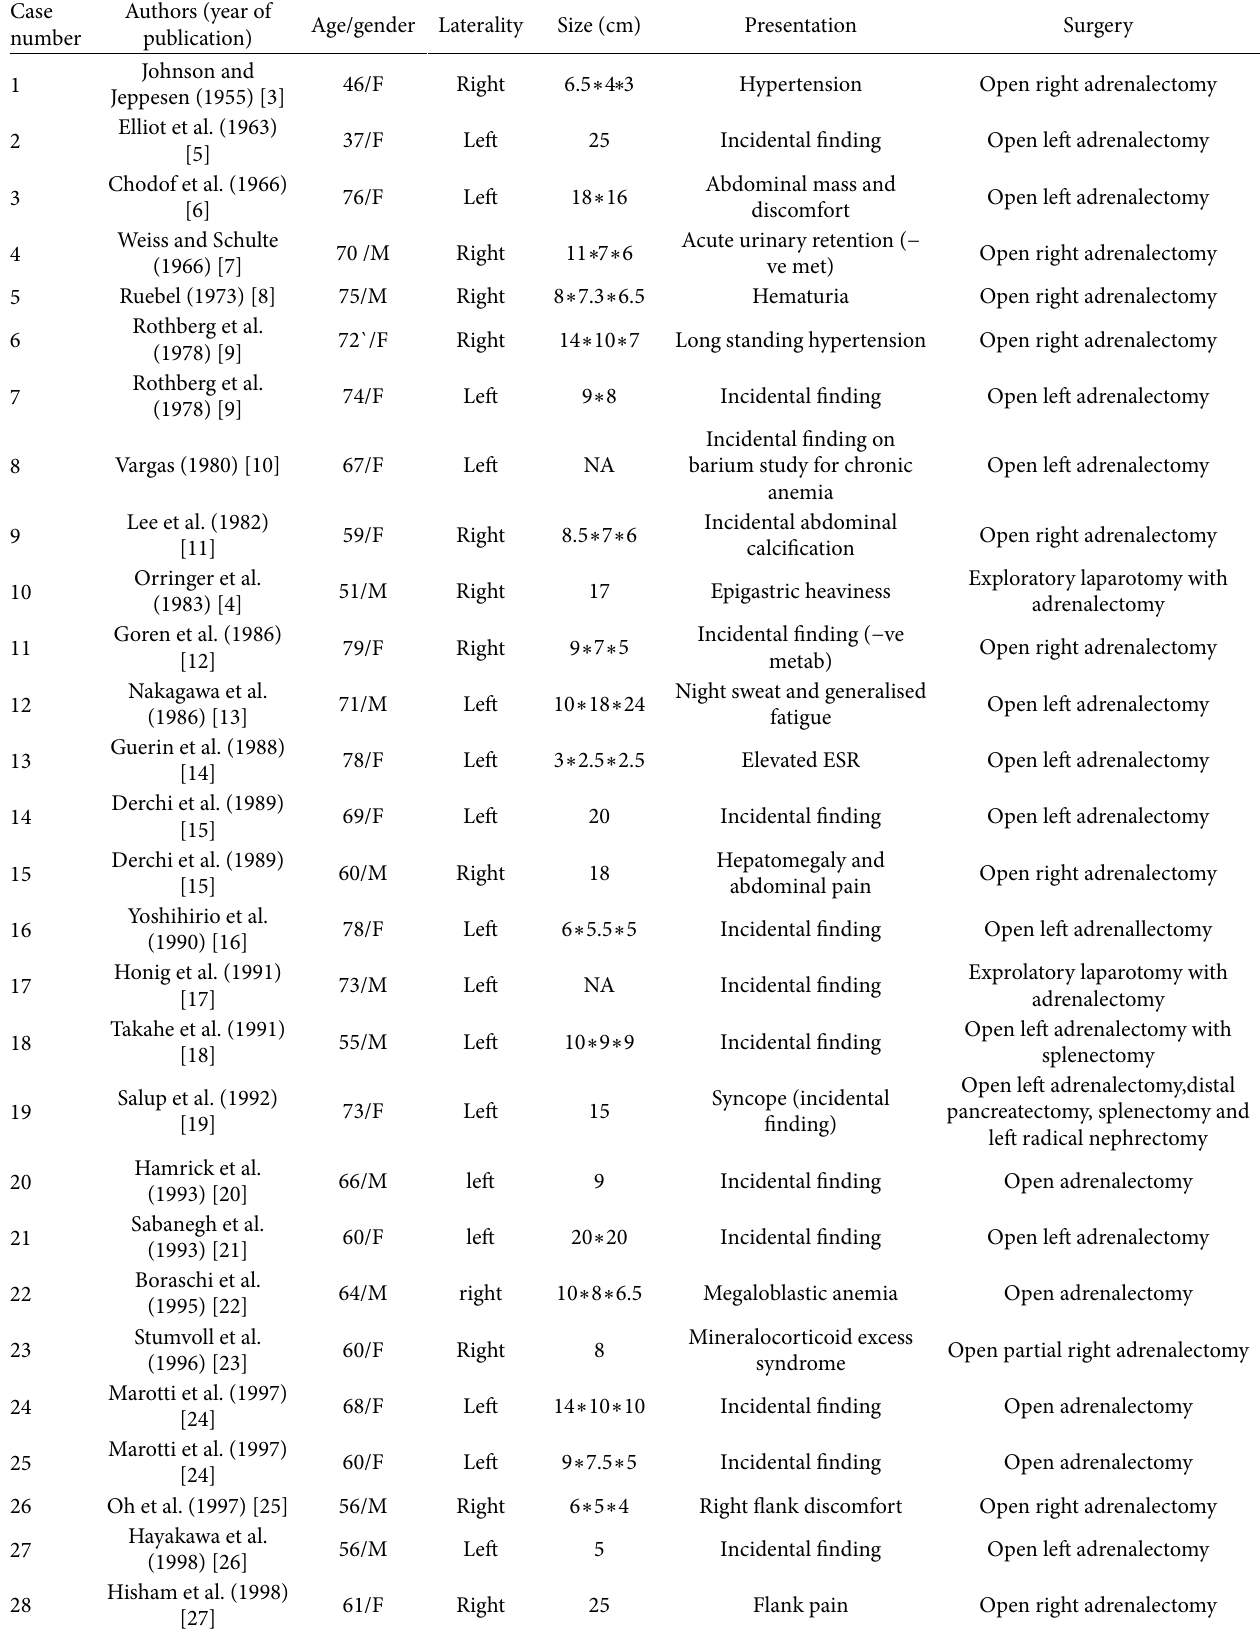
Table 1: List of all published cases of adrenal cavernous